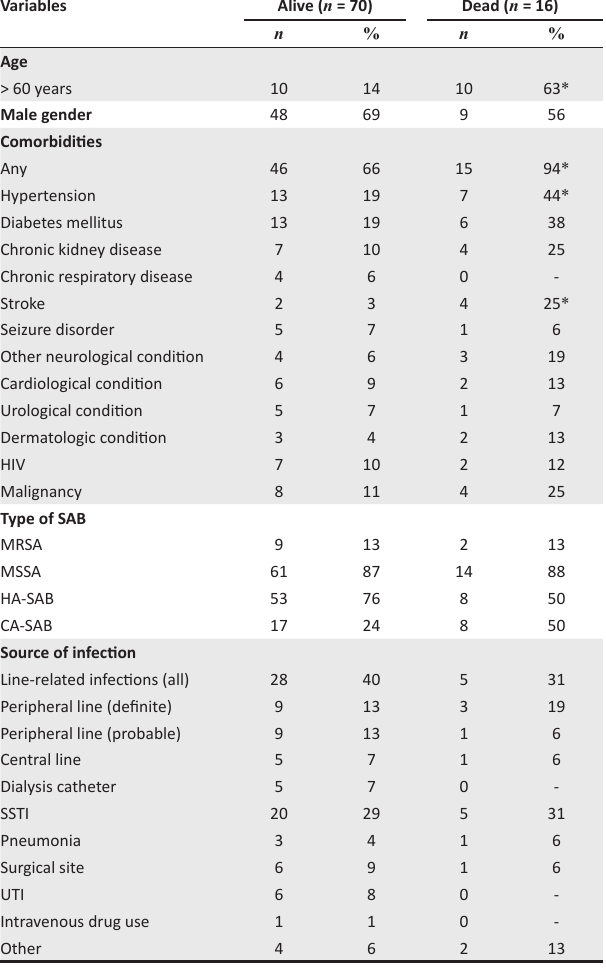
TABLE 3: Patients and clinical characteristics of patients who survived compared to those that died with Staphylococcus aureus bacteraemia. Variables